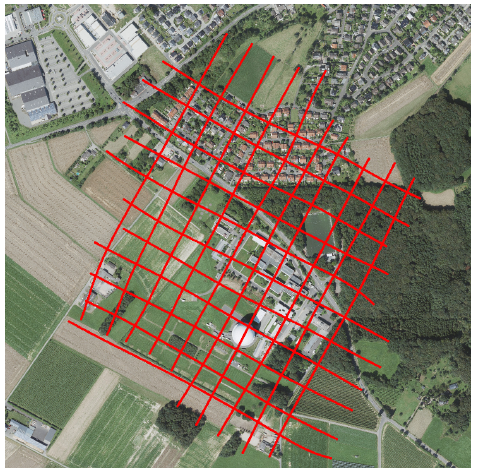
Figure 6. The cumulative error distribution for the whole Figure 5. GPS tracks belonging to the whole dataset of dataset. Images that could not be matched due to missing 4121 images. landmarks are described as n/a and plotted separately in